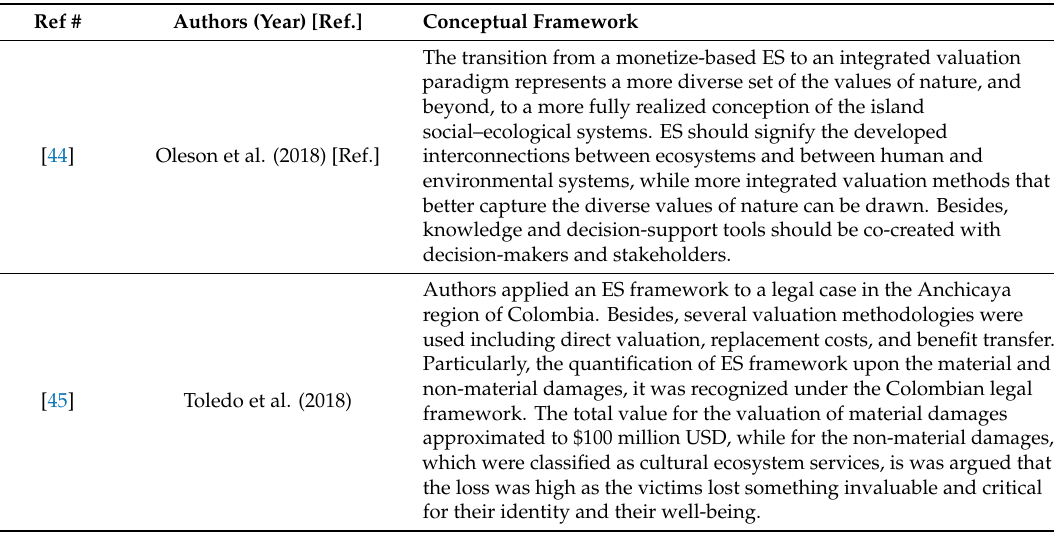
Table 3. Literature overview of ES under the thematic classification of “socio-cultural appreciation and payment